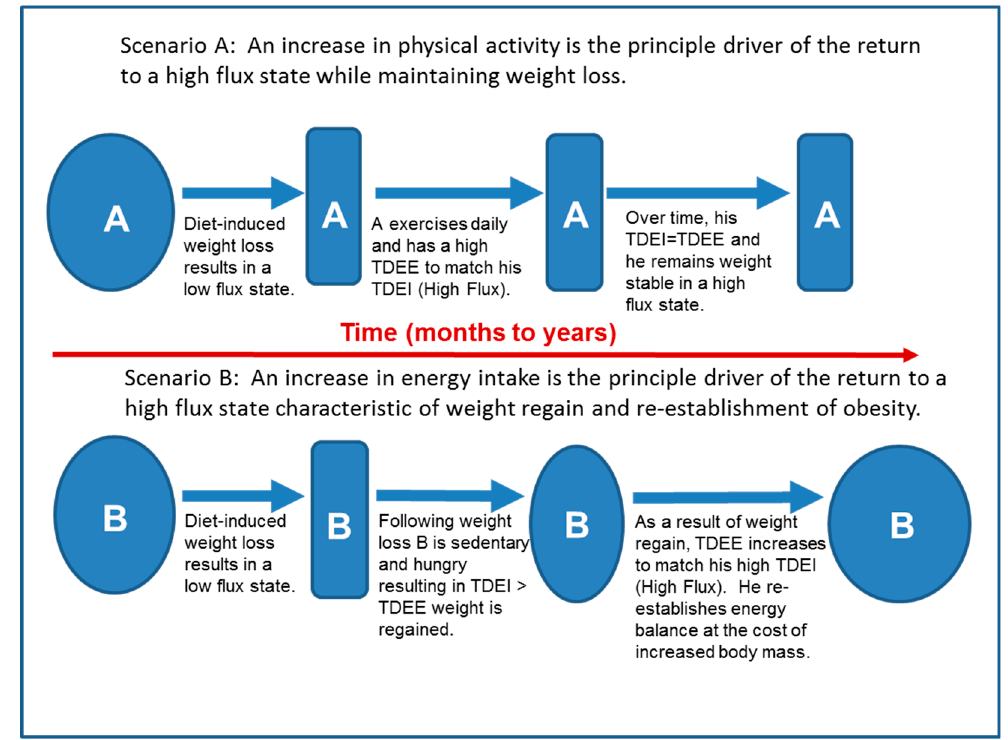
Figure 4. Two scenarios describing the different ways that a high energy flux state could be achieved following weight loss, with scenario A resulting in maintenance of lost weight, while scenario B results in a return to the obese